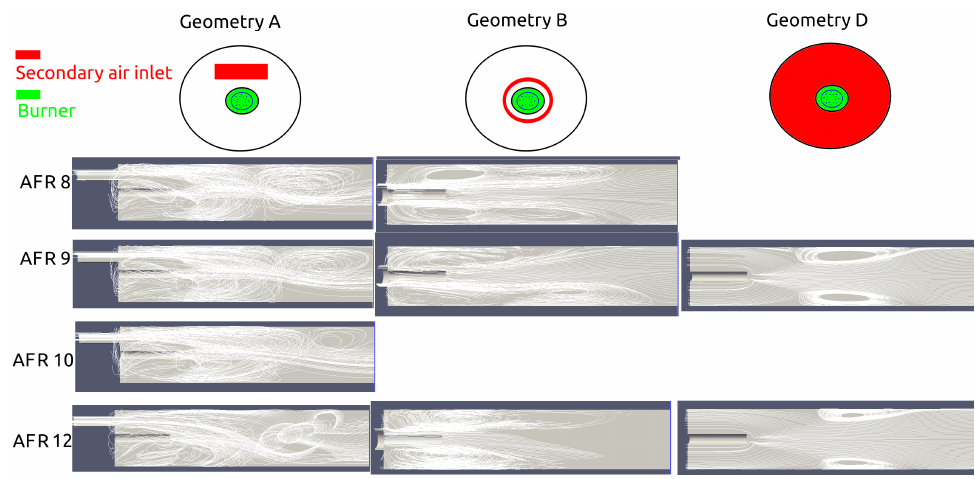
Figure 5. Stream patterns at different air–fuel ratio’s for the original kiln (geometry A), the modified kiln with annular air inlet (geometry B) and the modified kiln with co-flow air inlet over the entire lateral cross-section around the burner (geometry